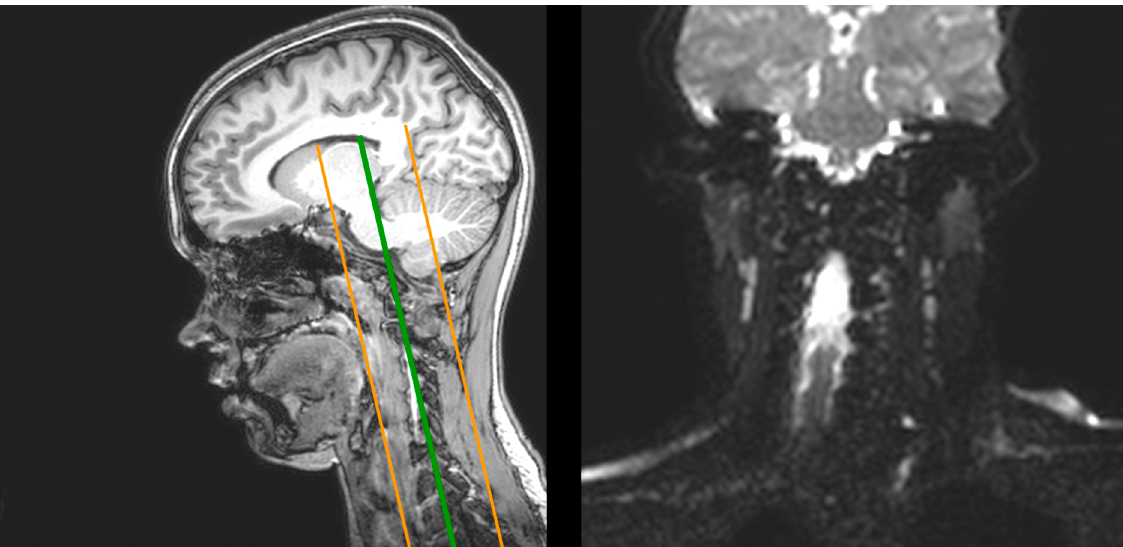
Figure 3. ( Left ) Over a sagittal view of the T1 anatomical slice, illustration of the coverage of the second diffusion MRI acquisition. (Right) Sample coronal view of the second diffusion MRI acquisition.